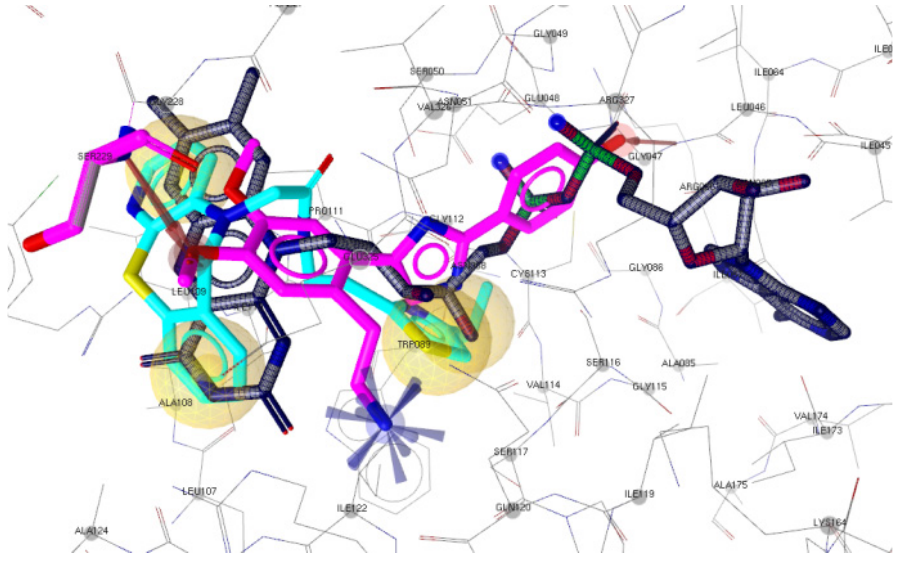
Figure 4. Superposition of compounds 3 (magenta), 2 (light blue), and FAD (gray) in E. coli MurB.